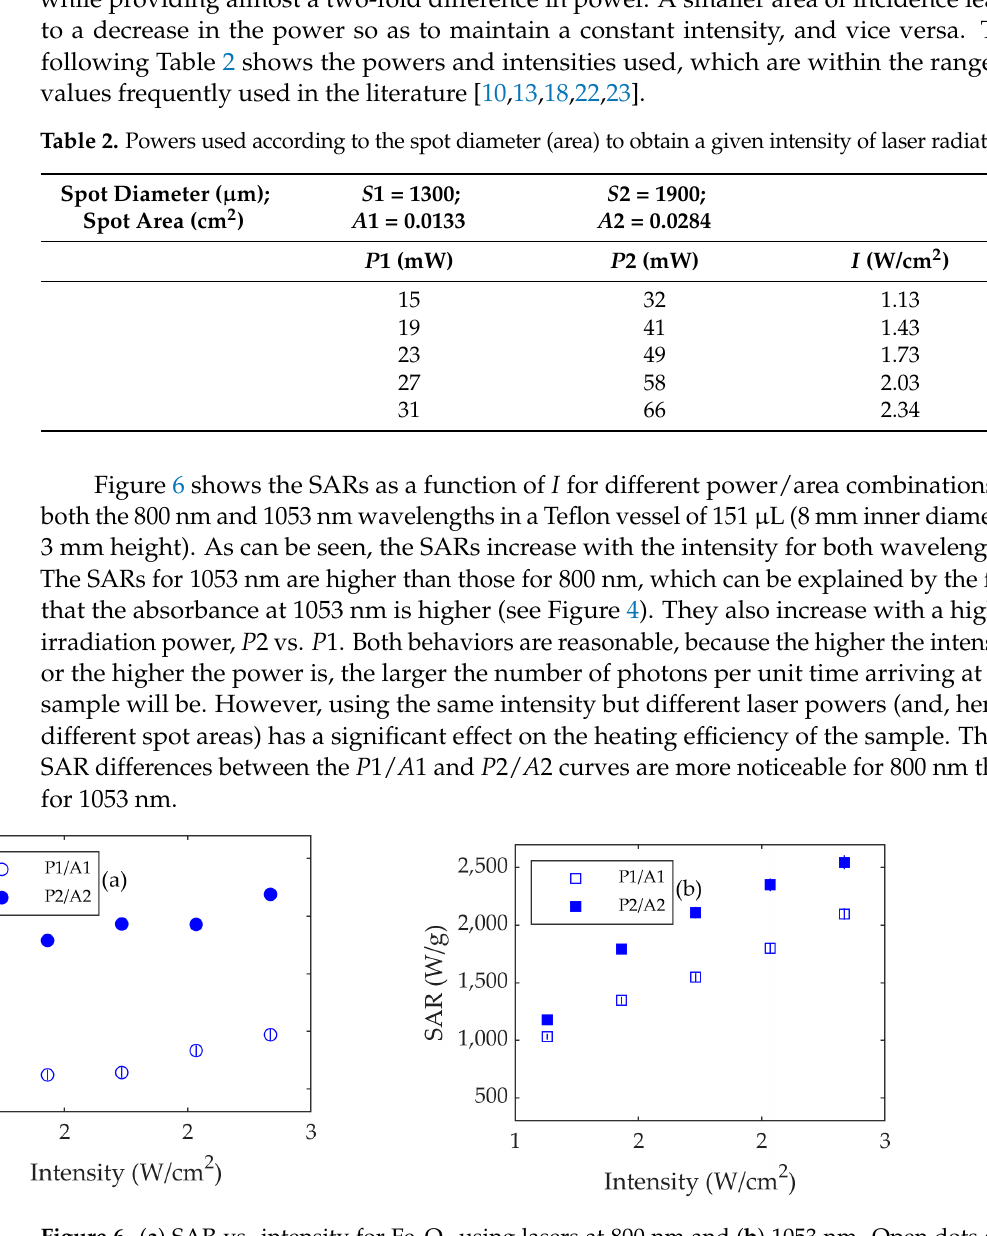
Figure 6. ( a ) SAR vs. intensity for Fe 3 O 4 using lasers at 800 nm and ( b ) 1053 nm. Open dots and squares stand for laser diameter S1 (1300 µ m), and full dots and squares stand for S2 (1900 µ m). A 1 and A 2 are the laser spot areas corresponding to S 1 and S 2. Errors are represented as vertical